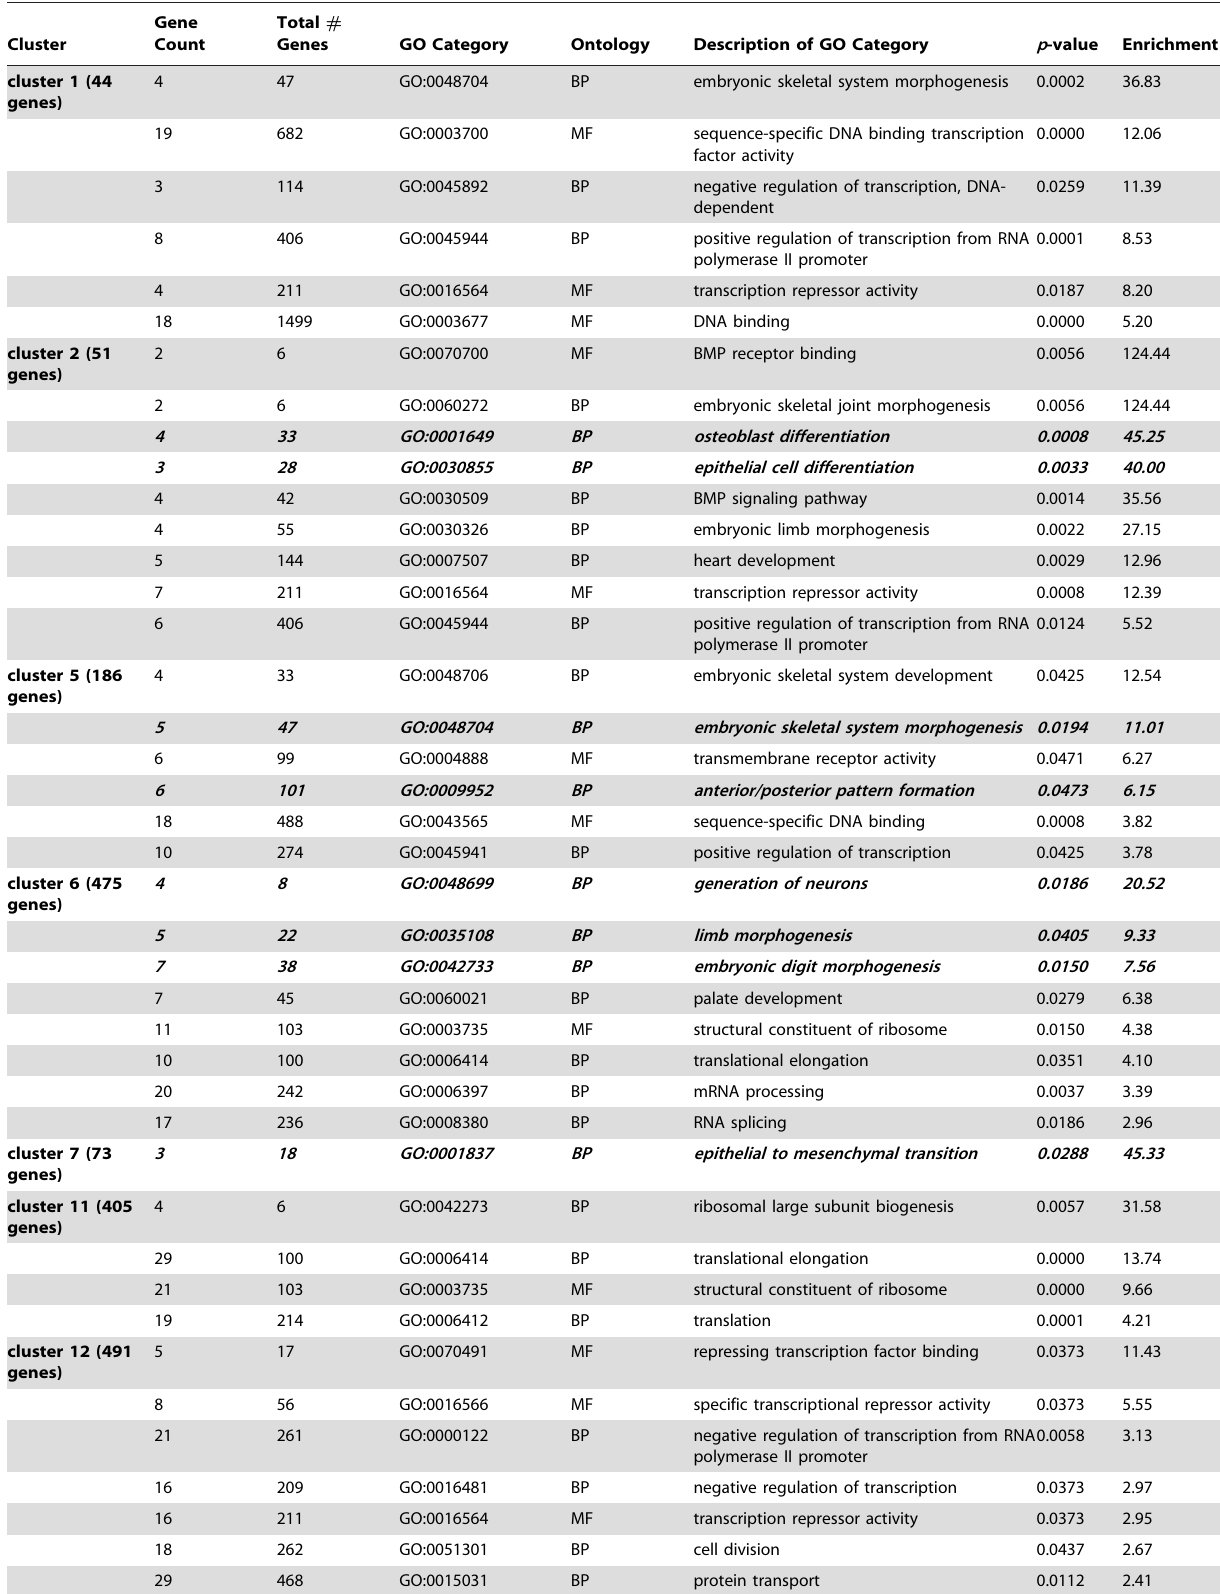
Table 2. Enrichment of functionally related genes in groups of co-expressed genes.